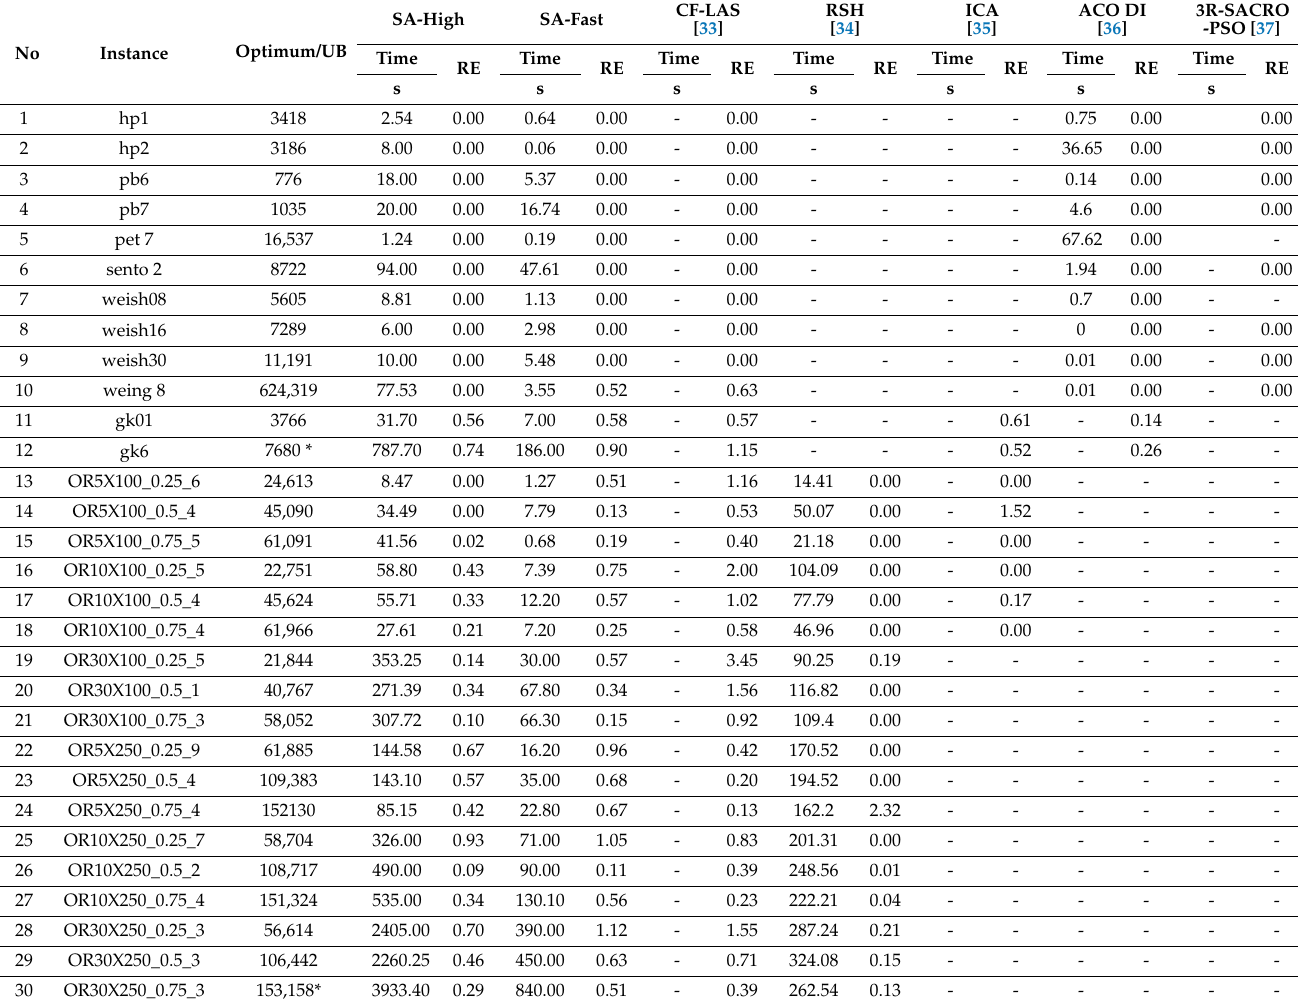
Table 10. Comparative efficiency and efficacy with other algorithms to MKP